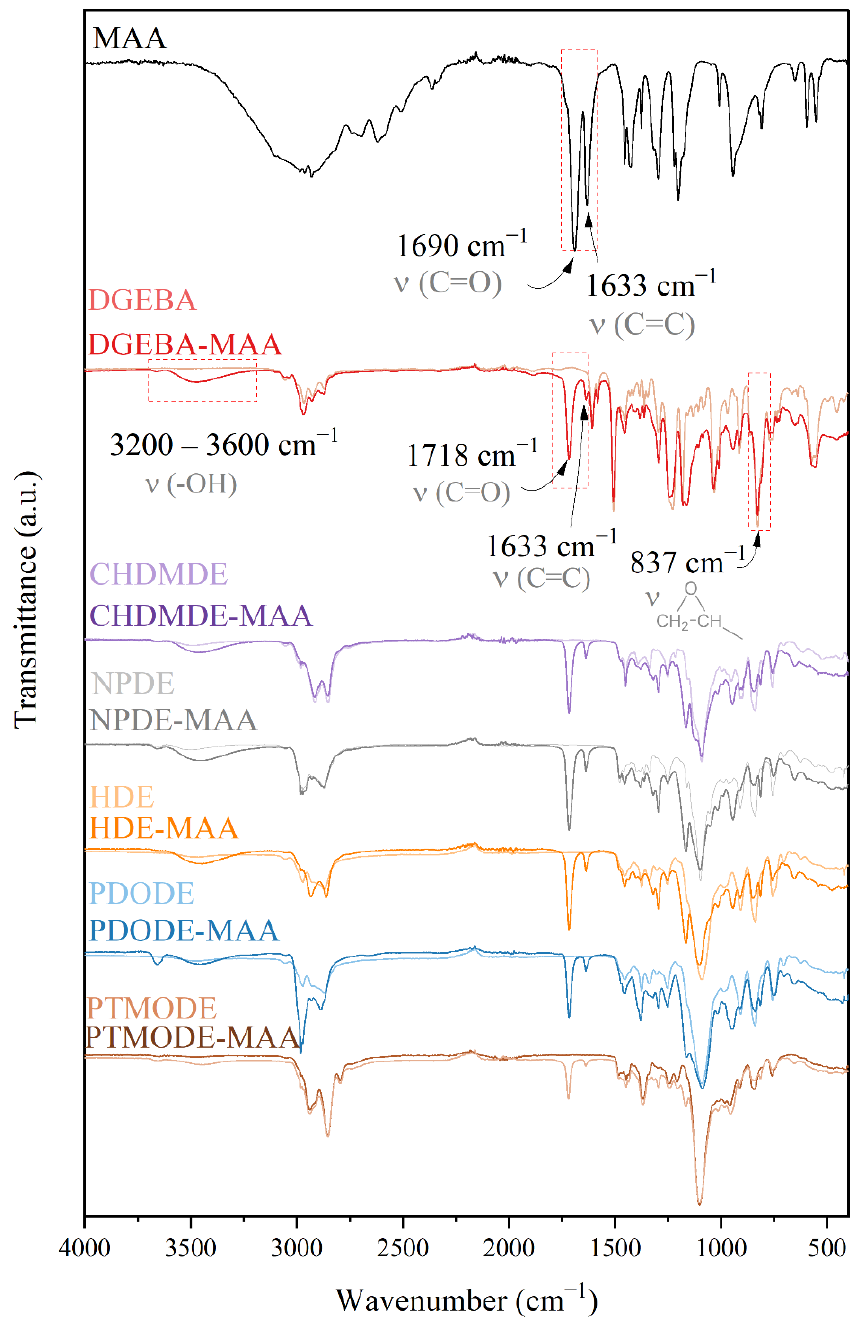
Figure 1. FT-IR spectra of reaction substrates and epoxy methacrylated